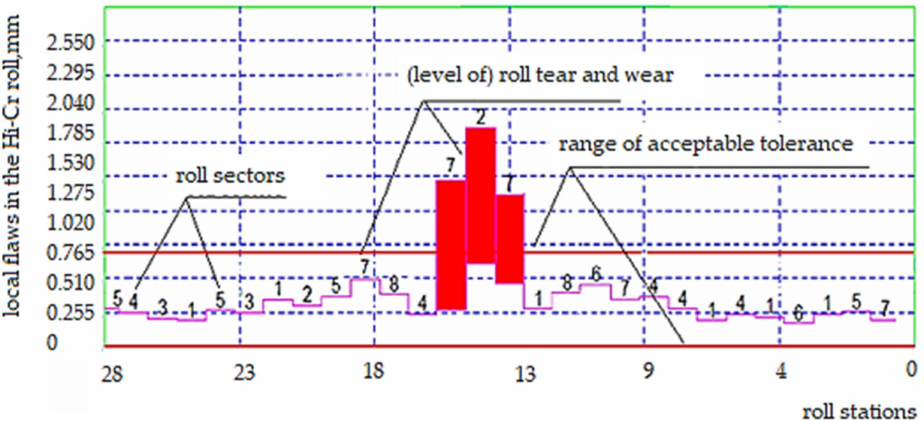
Figure 4. Diagram of faults level generated based on the map of faults for the high chromium Hi-Cr cast roll. Source: own, based on [38].